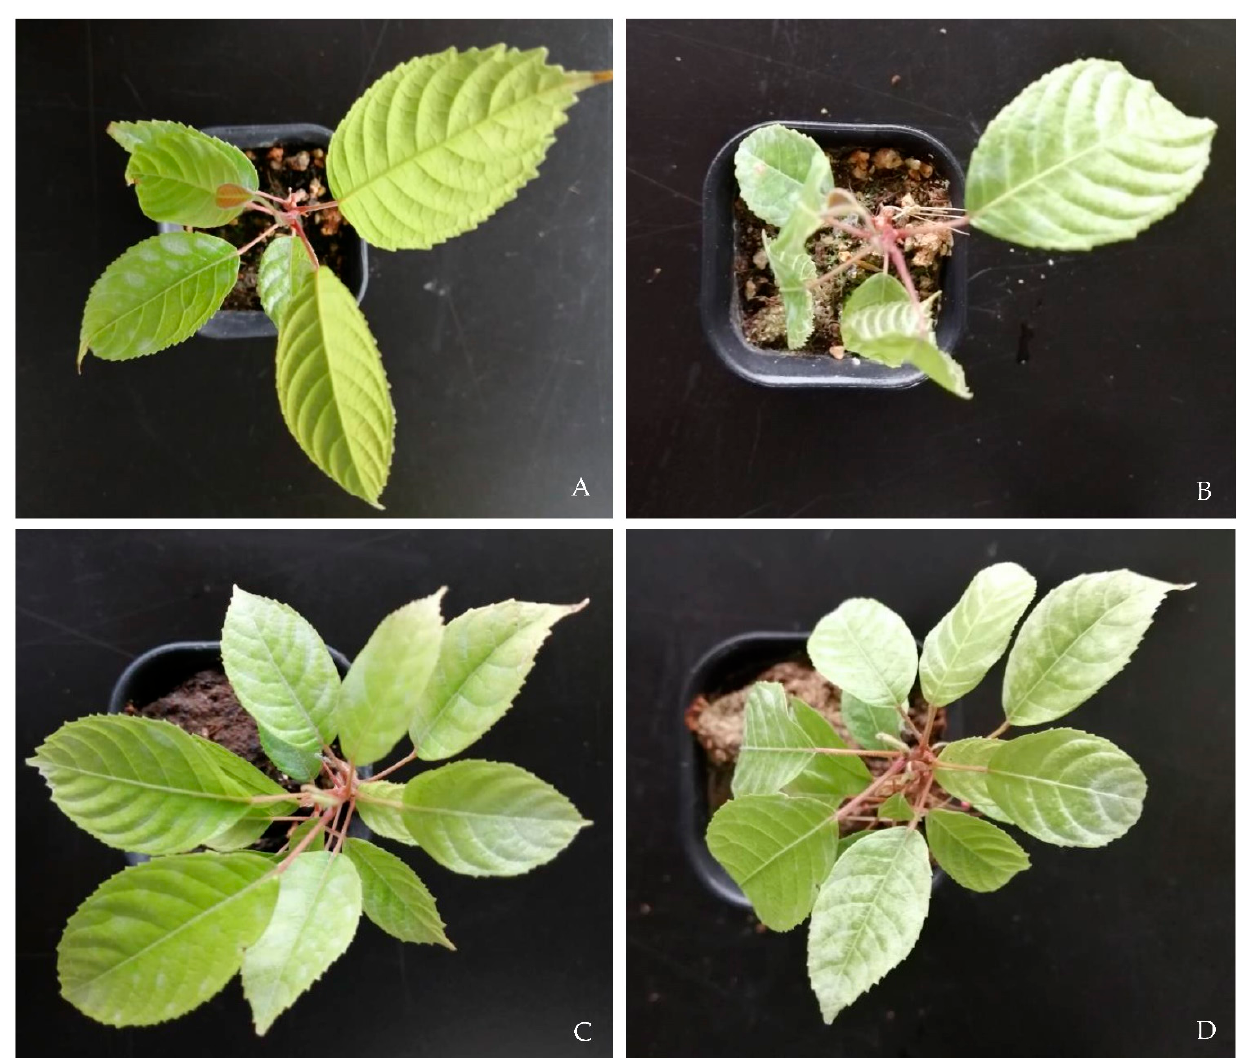
Figure 1. Typical phenotypes of QL ( A , B ) and RA ( C , D ) seedlings before and after low temperature treatment. ( A ) and ( C ) represent plants grown at 25 ℃ . ( B ) and ( D ) represent plants treated at − 3 ℃ for 24 h .